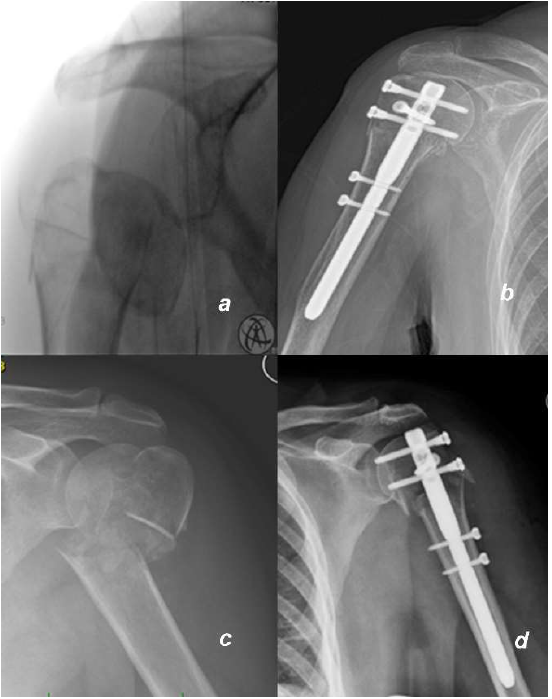
Figure 1. X-rays of fractures and osteosyntheses in two patients: ( a ) Fracture of proximal humerus in a 57-years-old man with intraarticular fracture 11C1.1 (AO) before and ( b ) 12 weeks after osteosynthesis with humeral intramedullary nail; as the nail is not protruding, only proximal locking screws would be removed during arthrolysis; ( c ) a 65-year-old woman with a proximal humerus fracture 11C3.1 before and ( d ) 6 weeks after osteosynthesis; the nail is protruding. All screws including the nail would be removed during arthrolysis.